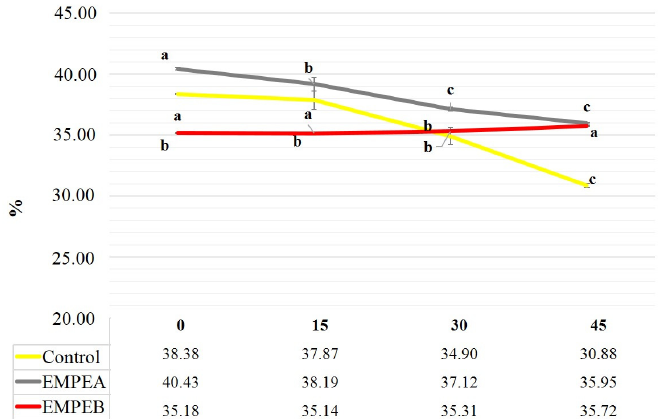
Figure 3. Changes in Moisture content in the samples during storage time. Different letters show differences for p <